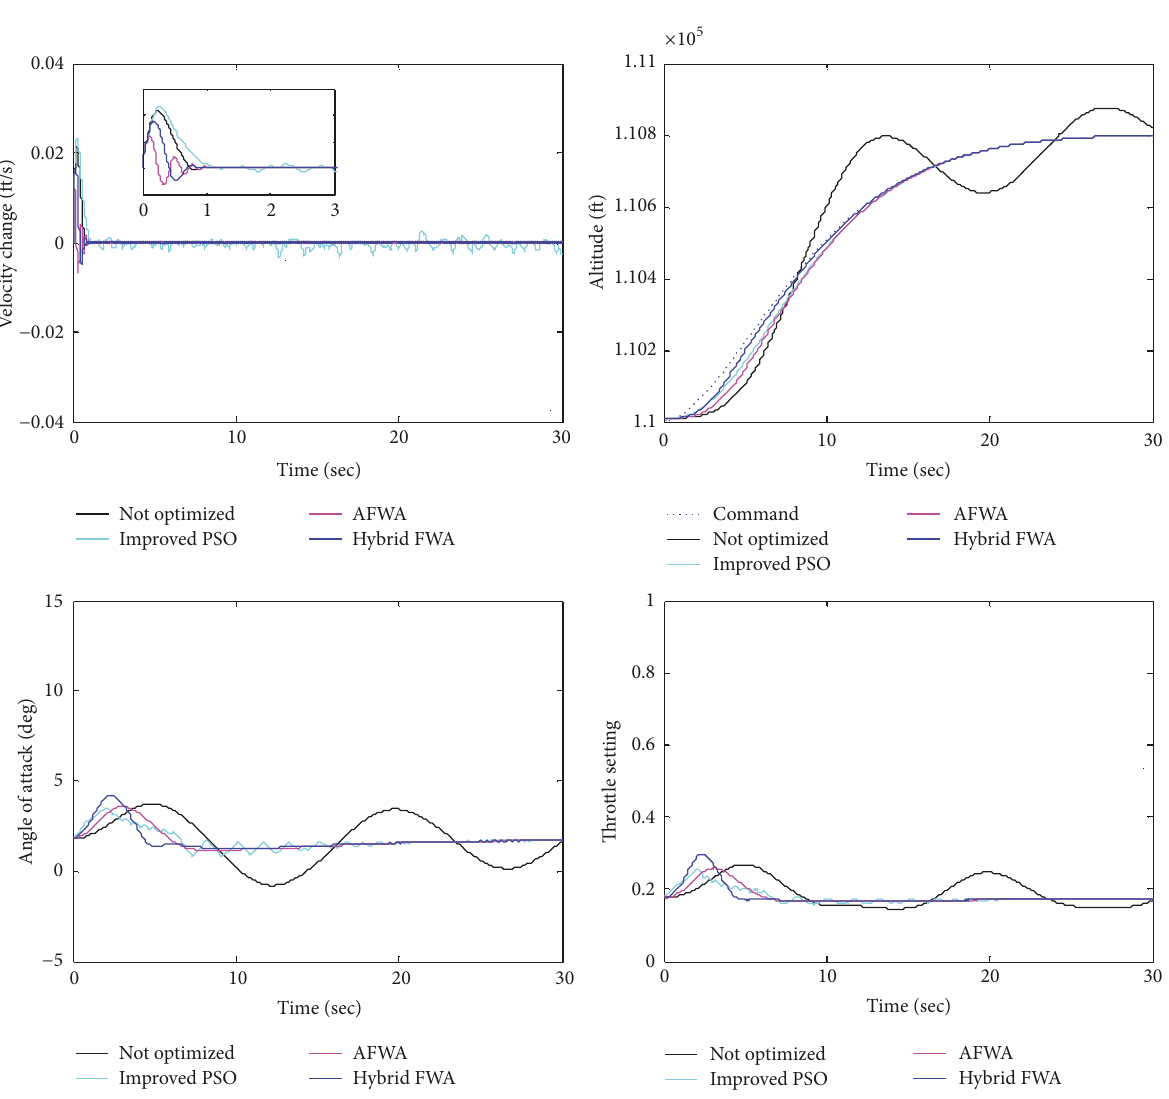
Figure 10: Tracking trajectories using various controller